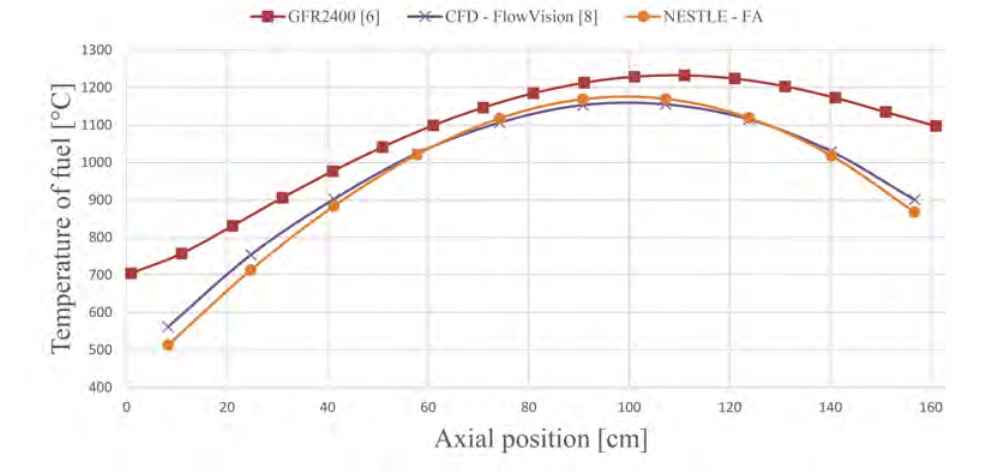
Figure 8. Results of the fuel axial temperature